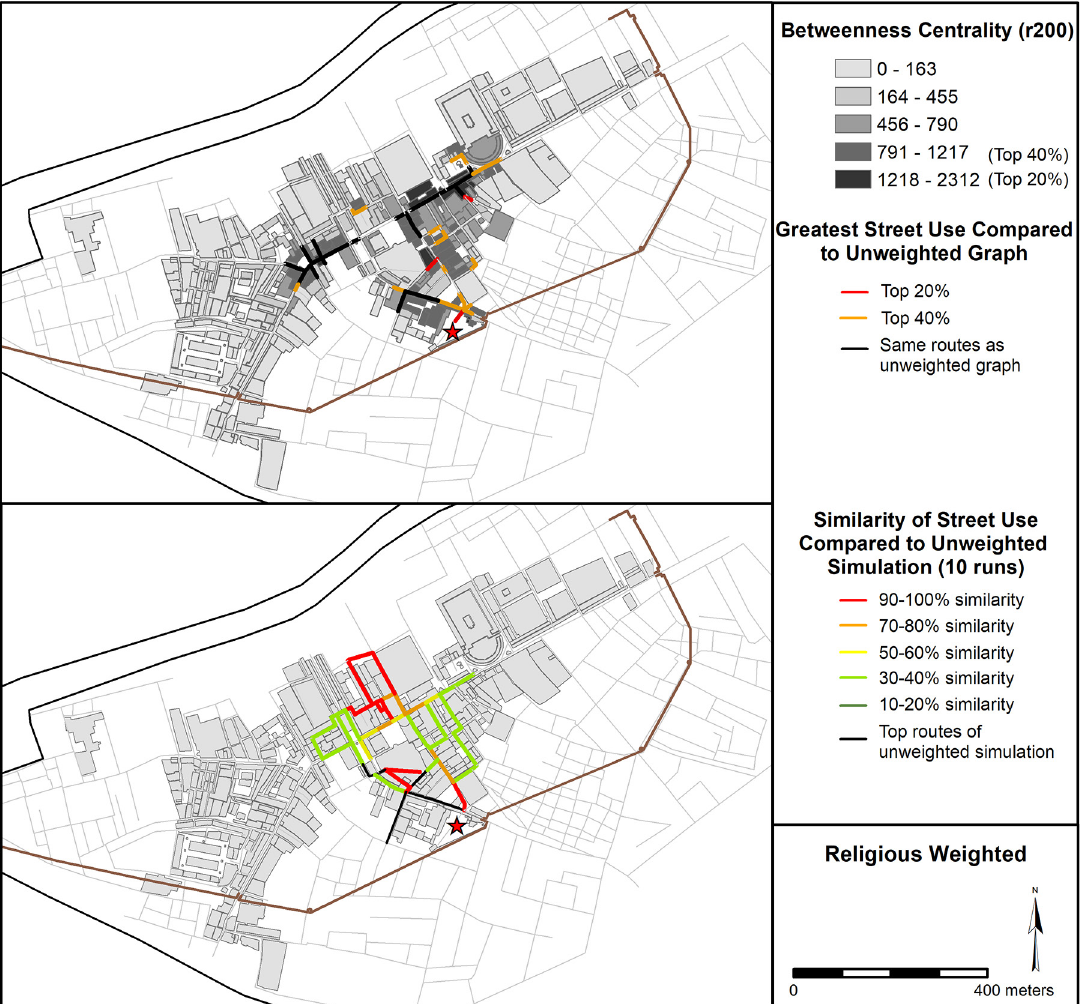
Figure 12. Top: Betweenness centrality graph weighted by religious buildings. Streets displayed in red and orange follow the highest betweenness centrality metrics which are different from the unweighted graph. Bottom: Similarity of street usage by processional runs weighted by religious